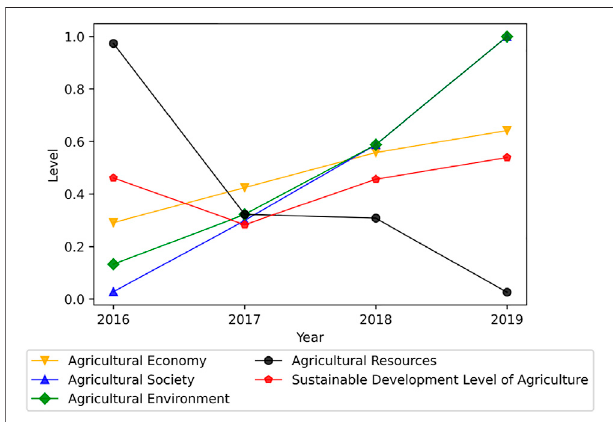
FIGURE 3 | Time evolution of SADL in jiangsu province from 2016 to